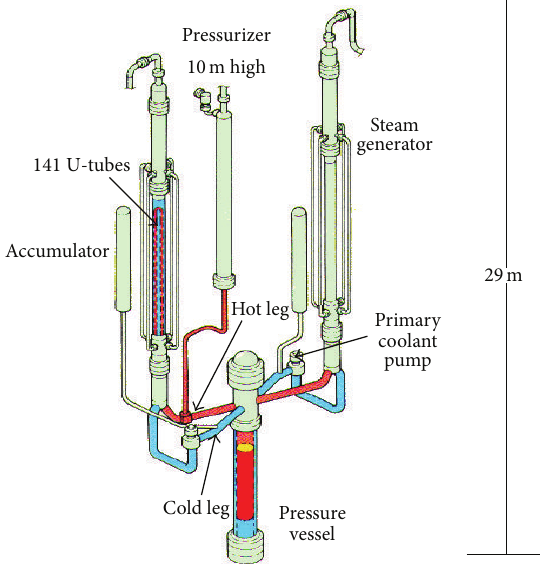
Figure 2: Schematic view of